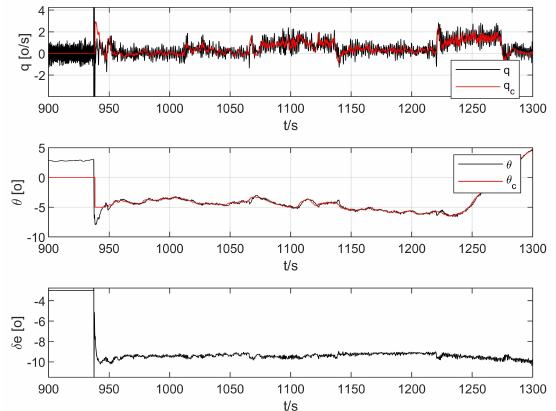
Figure 30. Flight test data. Command and response value of the pitch channel.